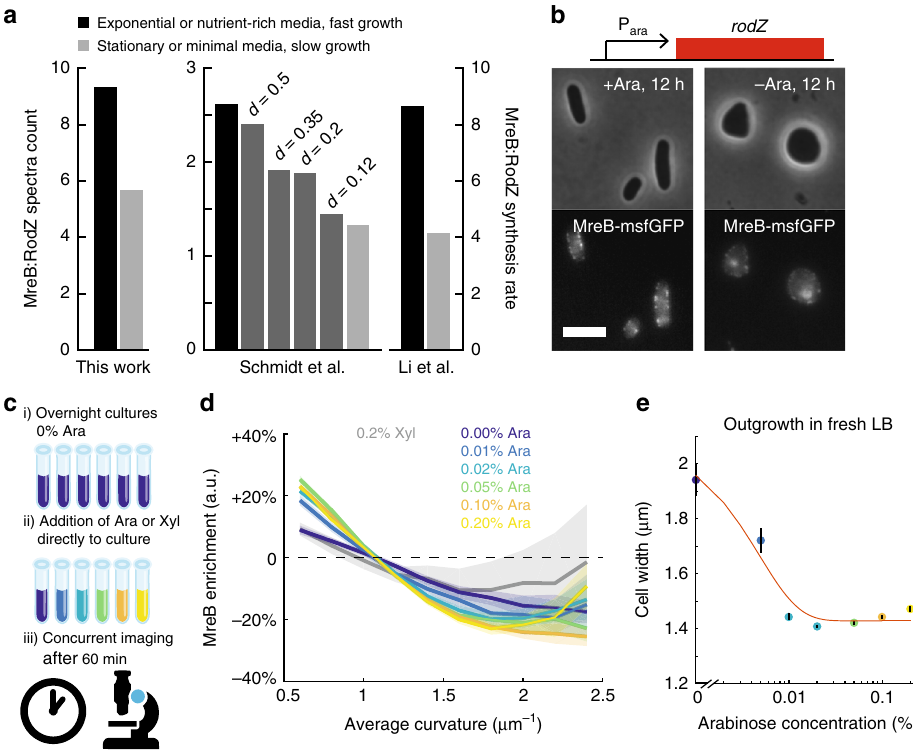
Fig. 2 RodZ expression drives changes in MreB curvature enrichment pro fi le. a The ratio of MreB to RodZ protein abundance consistently increases in a manner concordant with growth rate across multiple independent studies. d : chemostat dilution rate. b For a strain in which the native promoter of rodZ was replaced by P ara, RodZ expression is driven by arabinose (Ara). In the absence of arabinose, cells became spheroidal. Scale bar is 5 µ m. c Schematic of experimental approach in d . Overnight cultures grown in the absence of arabinose were further incubated after adding varying amounts of arabinose. The distribution of MreB fl uorescence was measured after 60 min. d After 1 h of growth, induction of RodZ by arabinose enhanced the depletion of MreB at high-average curvature in a dose-dependent manner. By contrast, the enrichment pro fi le was more uniform after induction with 0.2% xylose (Xyl) or 0% arabinose. Shaded areas represent the standard deviation of enrichment from resampled data for each condition. All bins include at least 50 observations. e Overnight cultures grown in 0% arabinose and back-diluted 1:10,000 into fresh LB with varying levels of arabinose exhibited dose-dependent steady- state widths after 4 h of growth. Black lines represent standard error of mean ( n > 50 contour of each cell. At 1.5 h (OD 600 ~ 0.05), MreB was generally